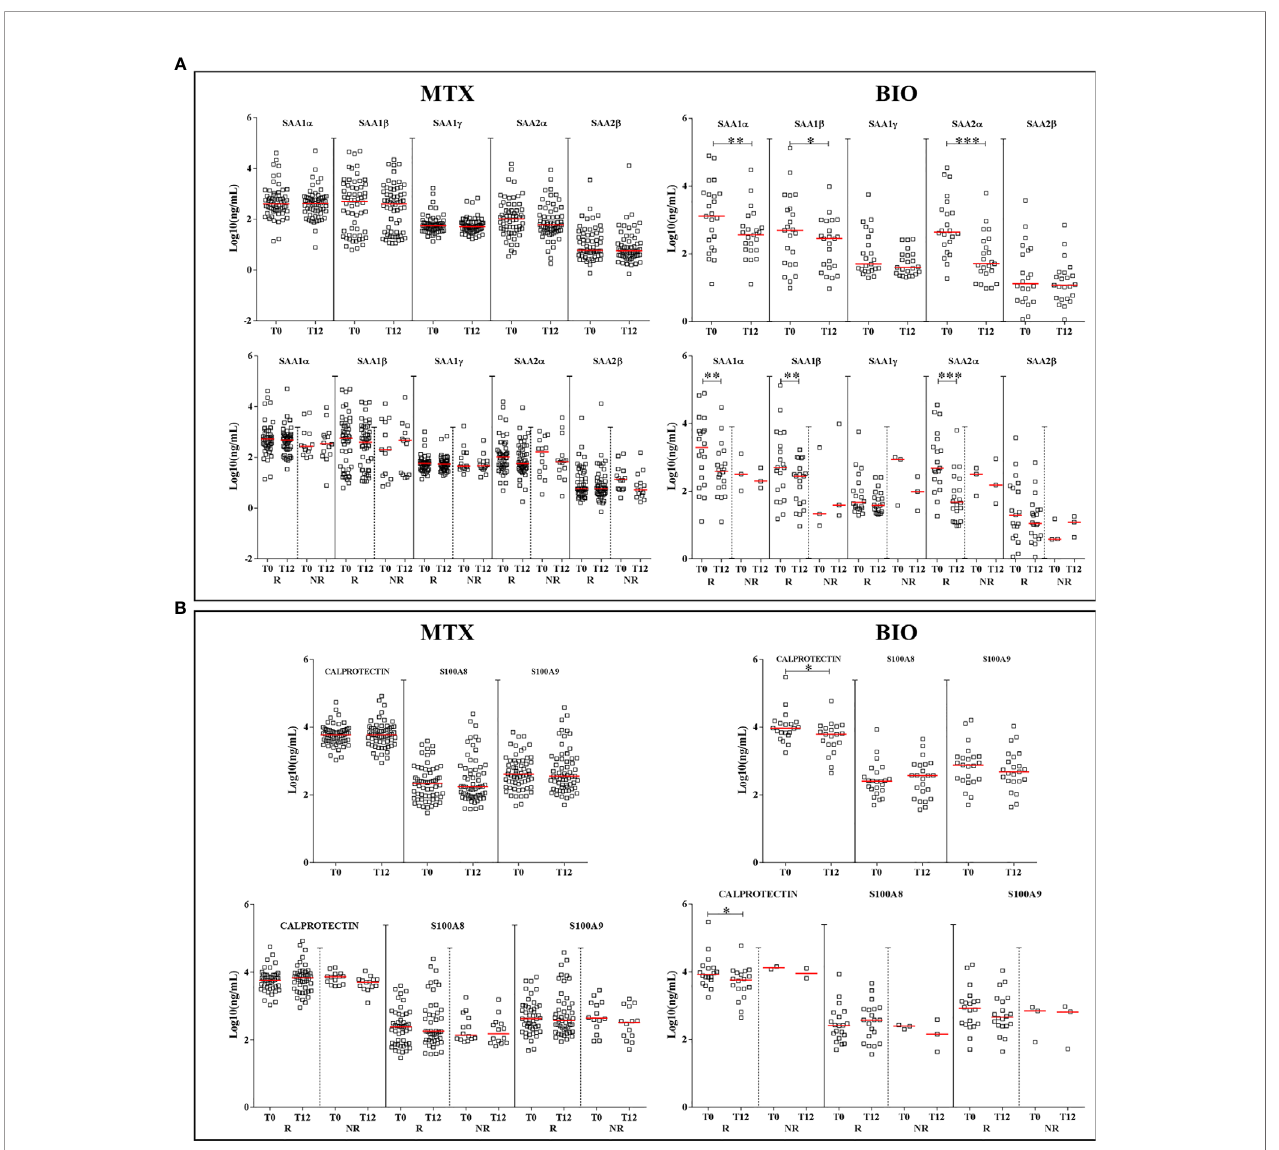
FIGURE 4 | Differences in the expression of proteins according to the treatment. Graphs depict the expression of A-SAA variants (A) and alarmins (B) in patients, at T0 and T12, sorted by treatment: methotrexate monotherapy (MTX) or biologics (BIO). Scatter dot plots represent the median with interquartile range. *p-value ≤ 0.05, **p-value ≤ 0.01, ***p-value ≤ 0.001 (Wilcoxon test). R, good responders; NR,